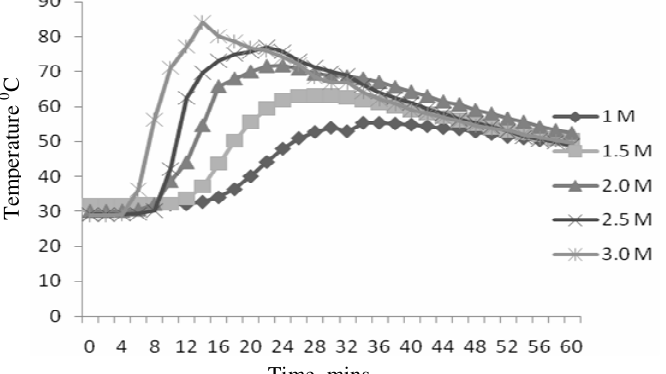
Figure 2. Variation of temperature with time for the dissolution of aluminium in different concentrations of HCl